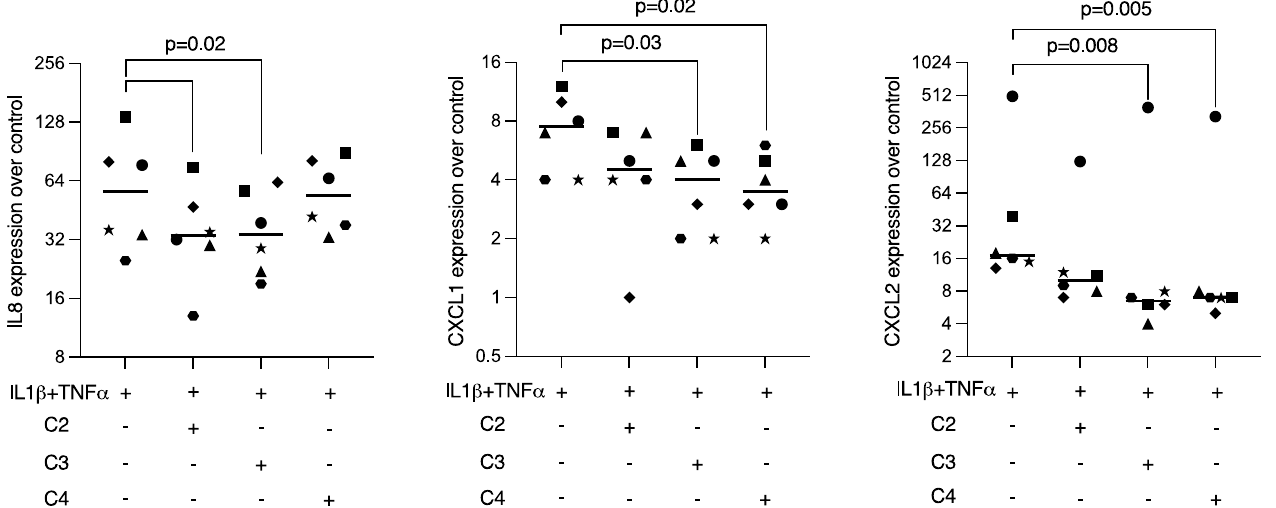
Figure 6. Propionate and butyrate suppressed the expression of CXCL1 and CXCL2 in HSC2 oral epithelial cells. Cells were exposed to 10 mM of acetate (C2), propionate (C3), and butyrate (C4) in the presence of 10 ng/mL IL1 β and TNF α . Each format shape represents data from individual experiments with the median. Statistical analysis was based on the Friedman test and corrected p values are indicated.